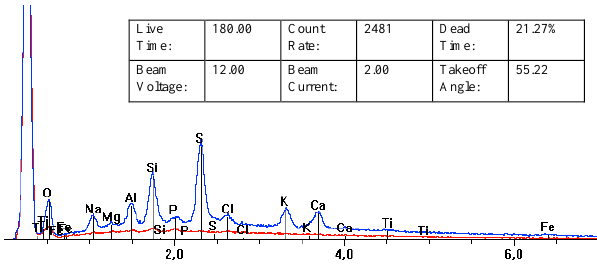
Fig. 3. Comparison of the chemical composition, determined by the EDS method, for the substances on a new filter (red line) and used filter (blue line); filter samples from figure 2